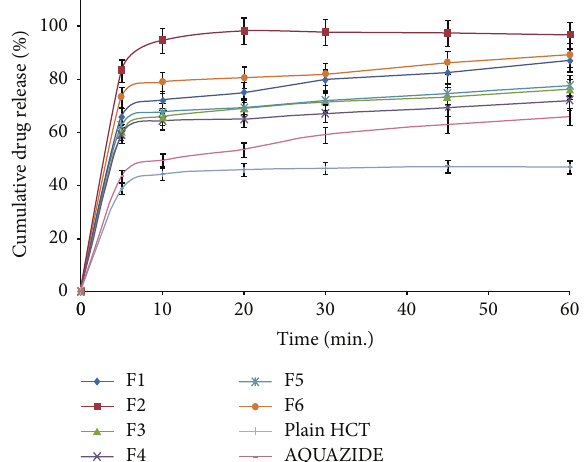
Figure 5: In vitro diffusion studies of F2, F4, and